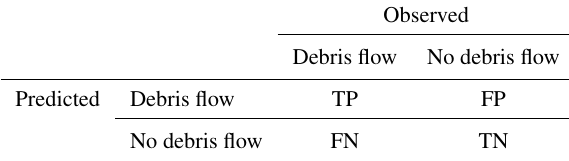
Table 4. Contingency